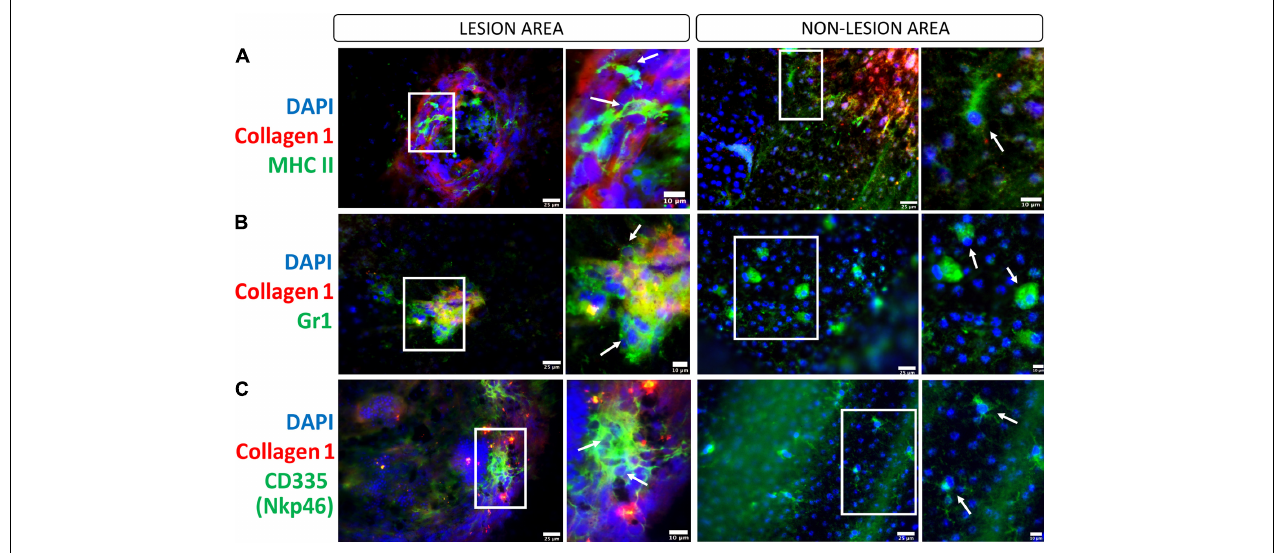
FIGURE 4 | Innate immune cells in the subretinal fibrotic lesion. Representative images, and their zoom in images, of the lesion (left panel) and non-lesion (right panel) areas of RPE flatmounts stained for collagen-1, DAPI and MHCII (A) , Gr-1 (B) , CD335/Nkp46 (C) . Scale bars = 25 µ m; Zoom images Scale bars = 10 µ m.